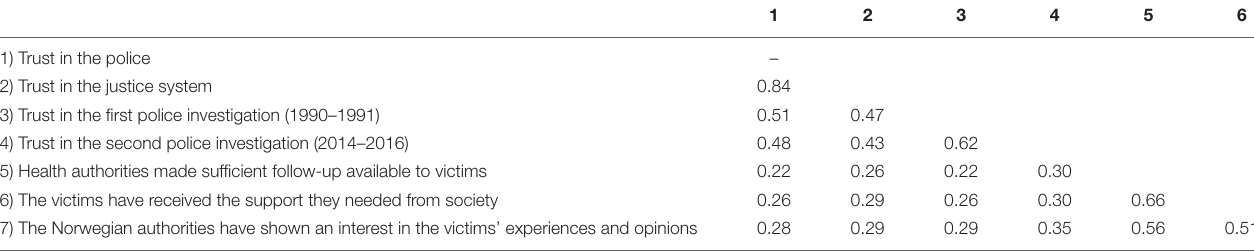
TABLE 3 | Correlations between perceptions about how authorities handled the disaster aftermath and current institutional trust.